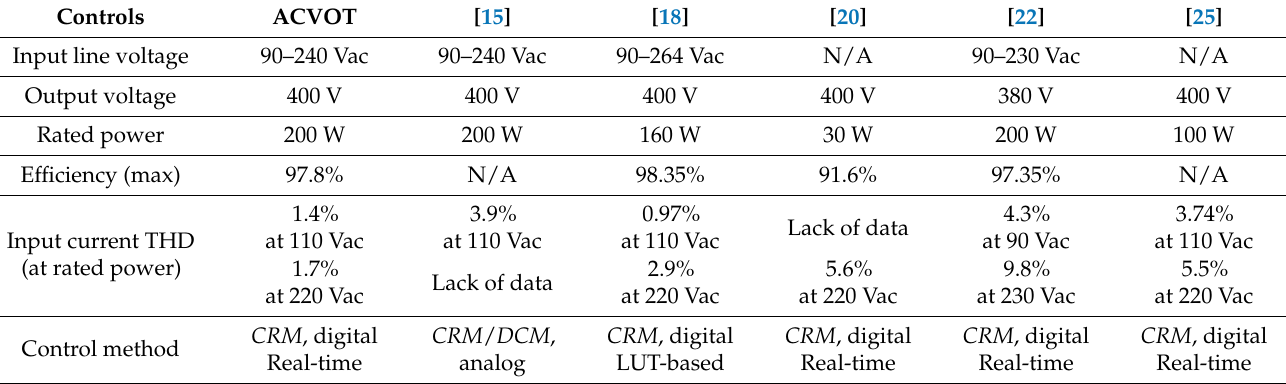
Table 6. Comparison of the different control